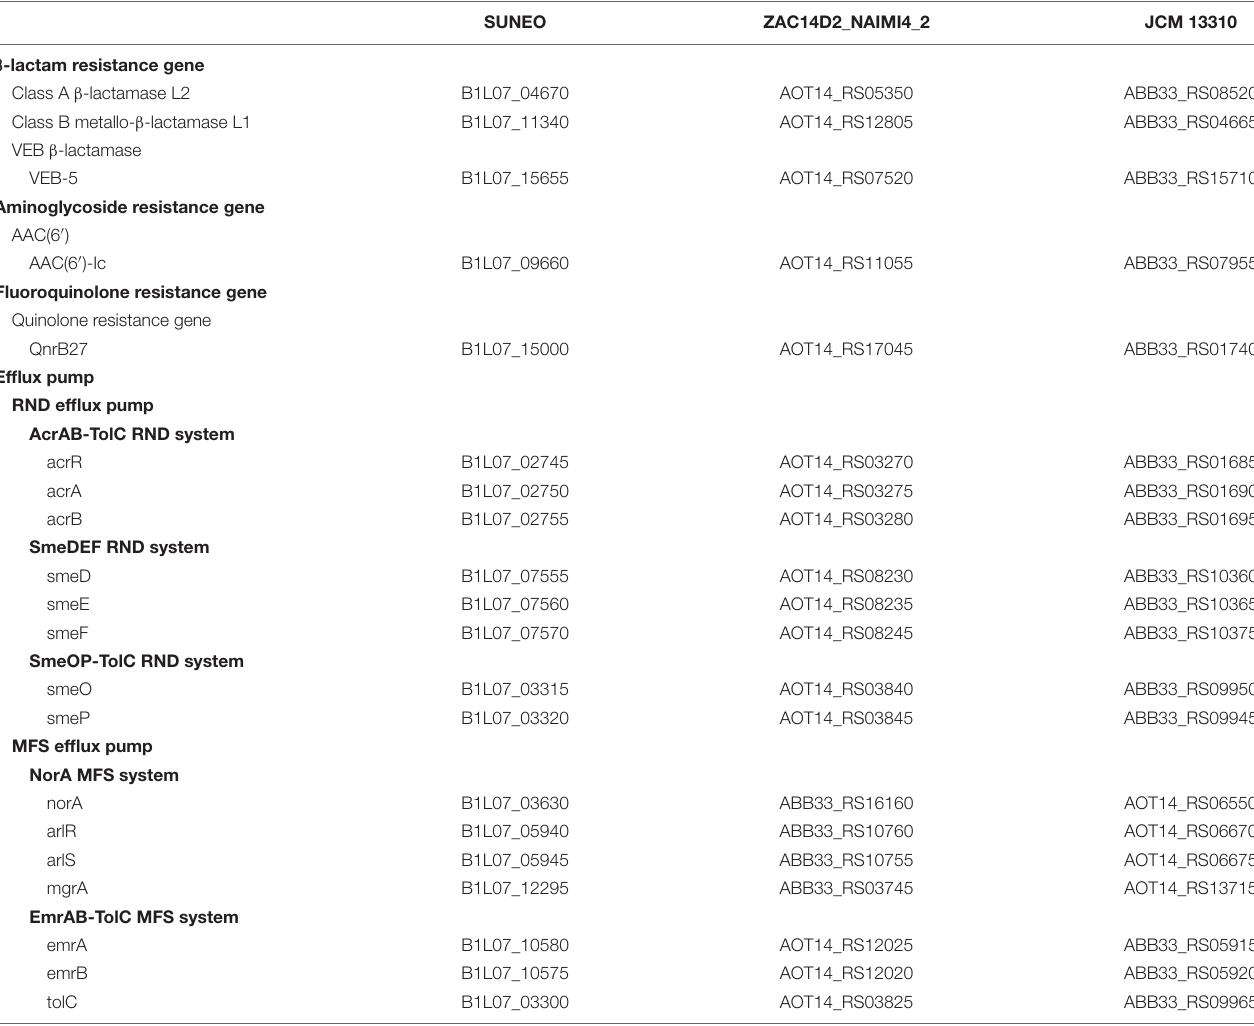
TABLE 4 | Summary of the antibiotic resistance genes among the three strains of S. acidaminiphila and their related locus tag.